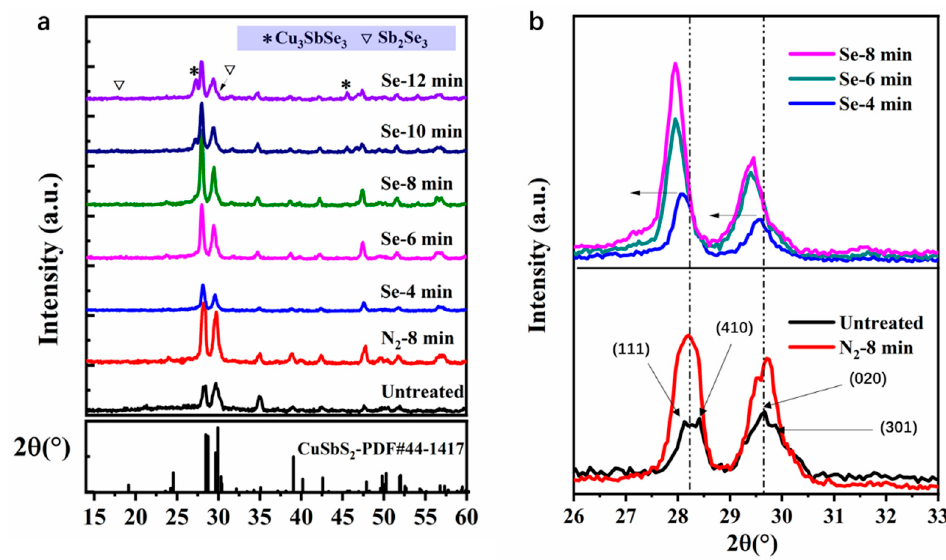
Figure 1. Crystal structure and composition analysis: ( a ) XRD analysis of the untreated film, and films annealed in N 2 and Se vapor and ( b ) Magnified XRD peaks of the annealed film and films selenized for 4, 6, and 8 min.